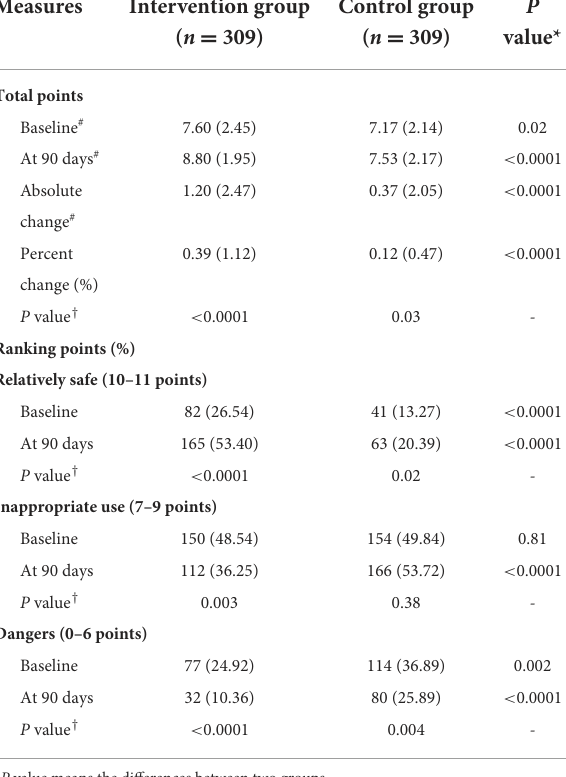
TABLE 9 The medication behavior compliance evaluation of elderly patients with multimorbidity.